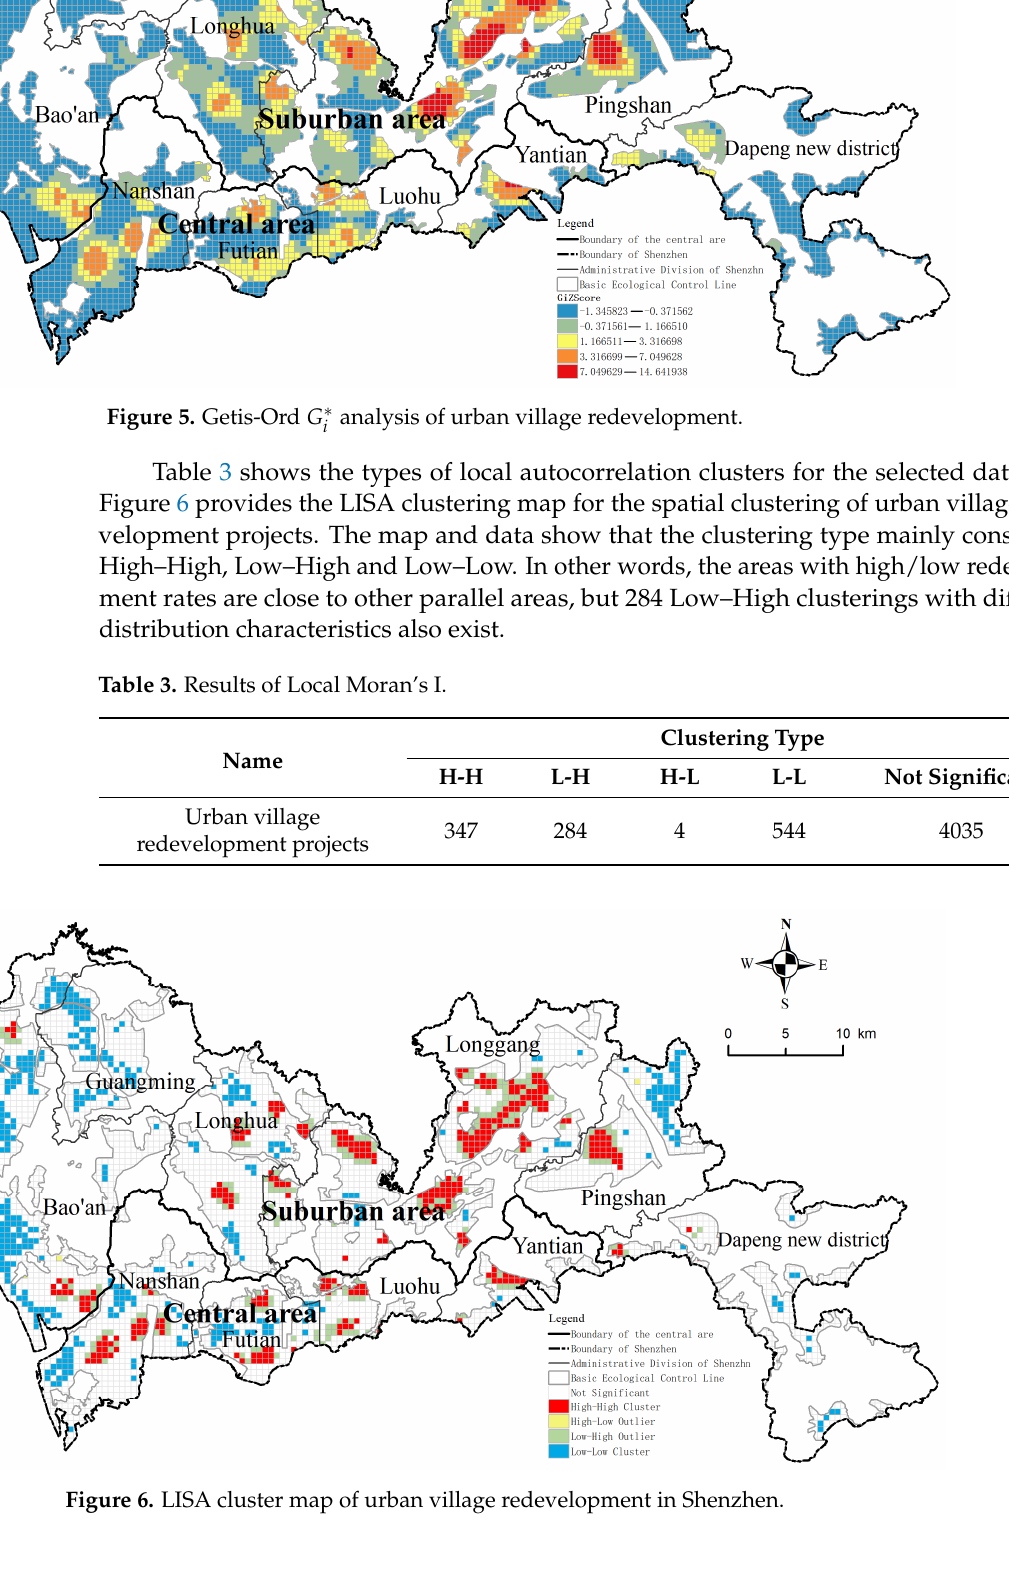
Figure 6. LISA cluster map of urban village redevelopment in Shenzhen.